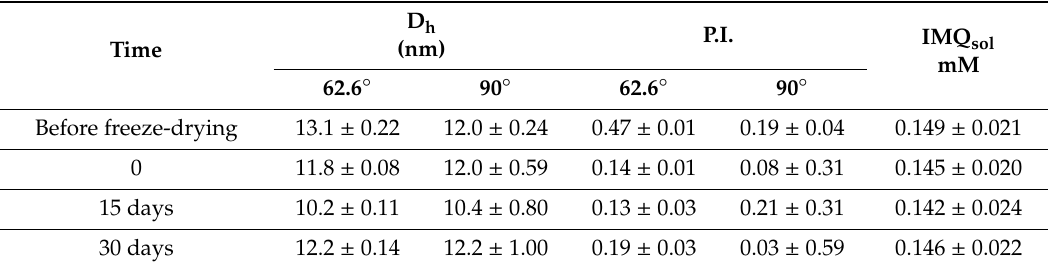
Table 6. Stability evaluation of C 7 C 13 CO-HTMG-TPGS-IMQ / Nano before and after freeze-drying at di ff erent times of